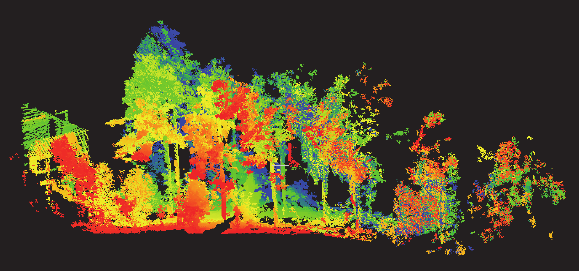
Figure 2. An example of a BLS patch. The colour coding spanning from red to blue illustrates the point time within the 10 seconds time